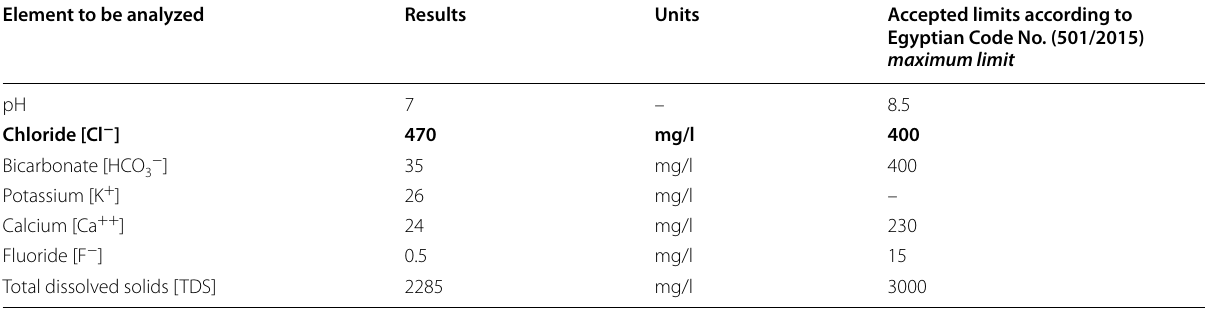
Bold are indicates the high levels of pollutants